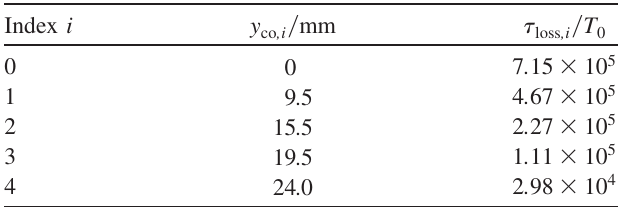
Fig. 2. The vertical beta function at s BPM is assumed to